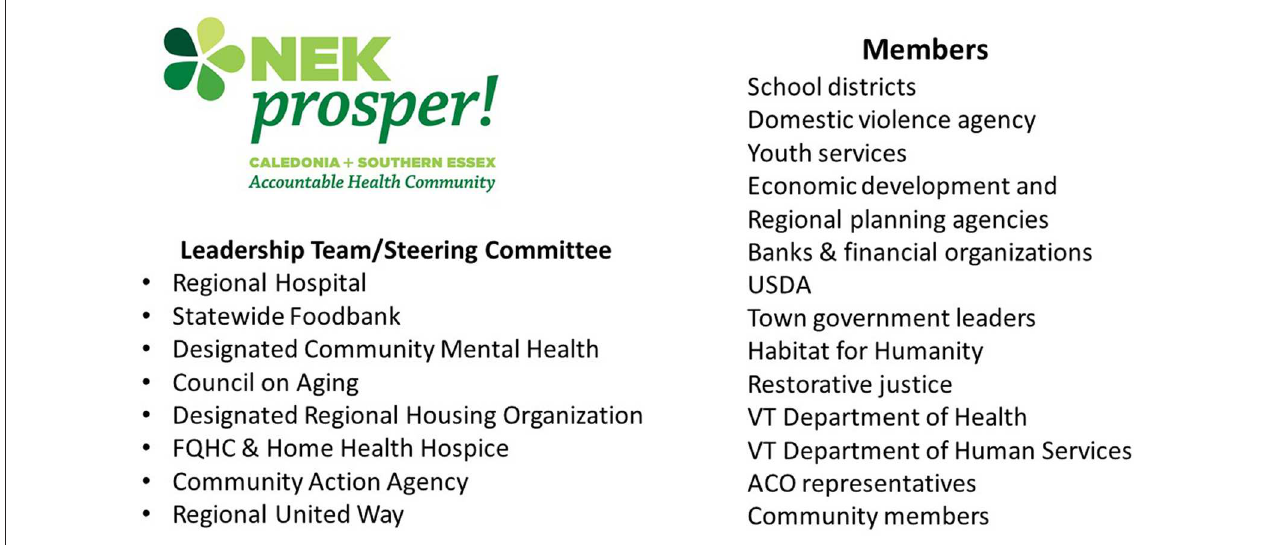
FIGURE 1 | Member Organizations for NEK